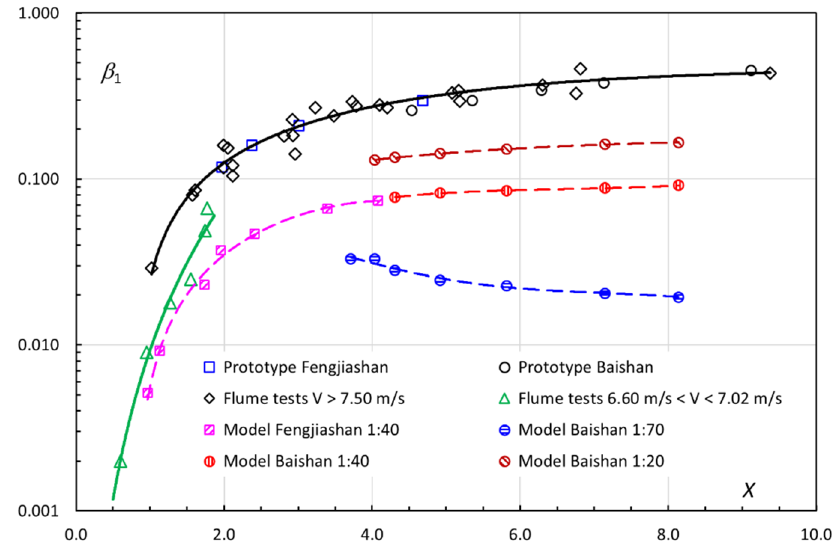
Figure 11. Comparisons of air demand ( β 1 - X ) among IWHR high-velocity flume tests, and model and prototype data from the Fengjiashan and Baishan aerators (adapted from [12]).